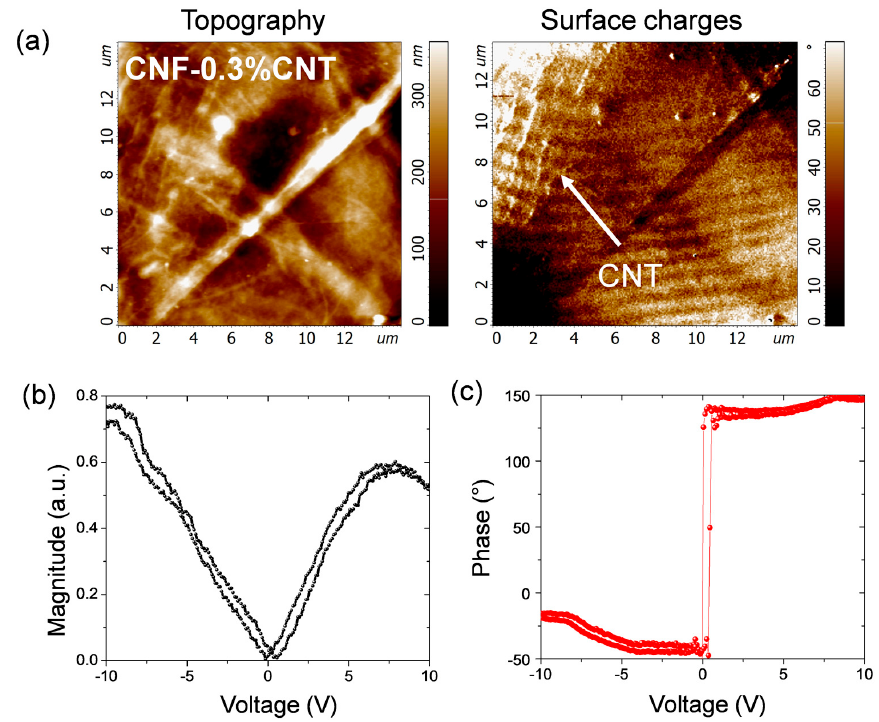
Figure 9. Topography and surface charge measurements obtained on the CNF-0.3%CNT sample ( a ). Force spectroscopy measurements showing the magnitude and phase of the local piezoelectric loop acquired on the CP sample ( b , c